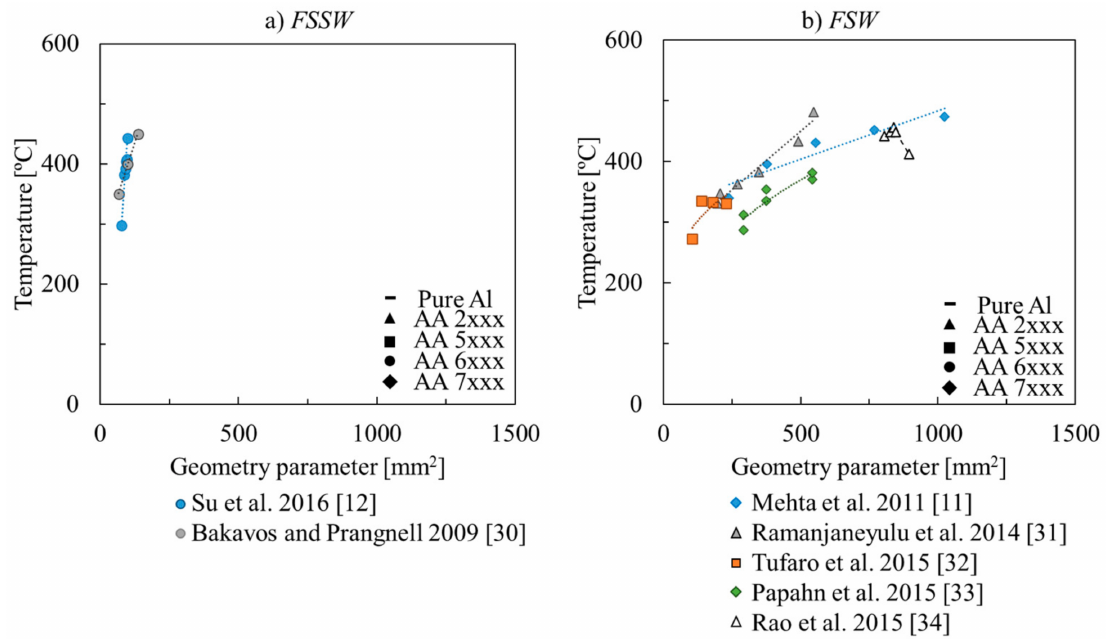
Figure 3. Evolution of the temperature with the geometry parameter for the experimental works considered in Table 1 on ( a ) FSSW and ( b ) FSW